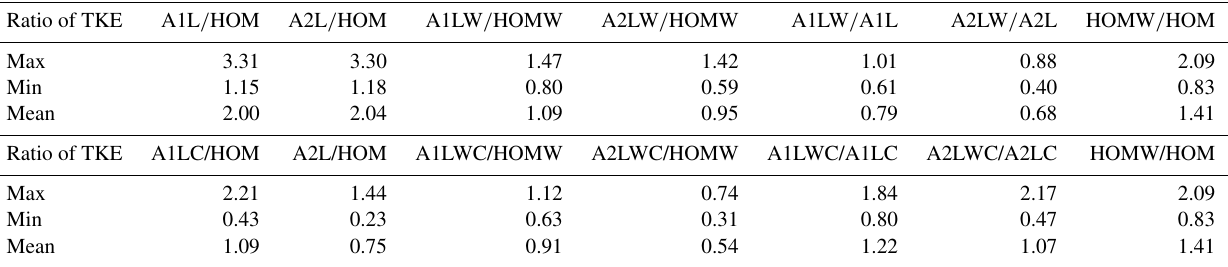
Figure 6. The y – z cross sections of the TKE (contour) with superimposed wind vectors composed of v and w wind for runs with (d–f) and without (a–c) background wind over homogeneous (a, d) and heterogeneous (b, c, e, f) surfaces. The thick black lines on the y axis represent the lake patches. Table 2. The ratio of the TKE of the different runs. Max, Min, and Mean stand for the maximum, minimum, and mean ratios of the TKE in the model domain,